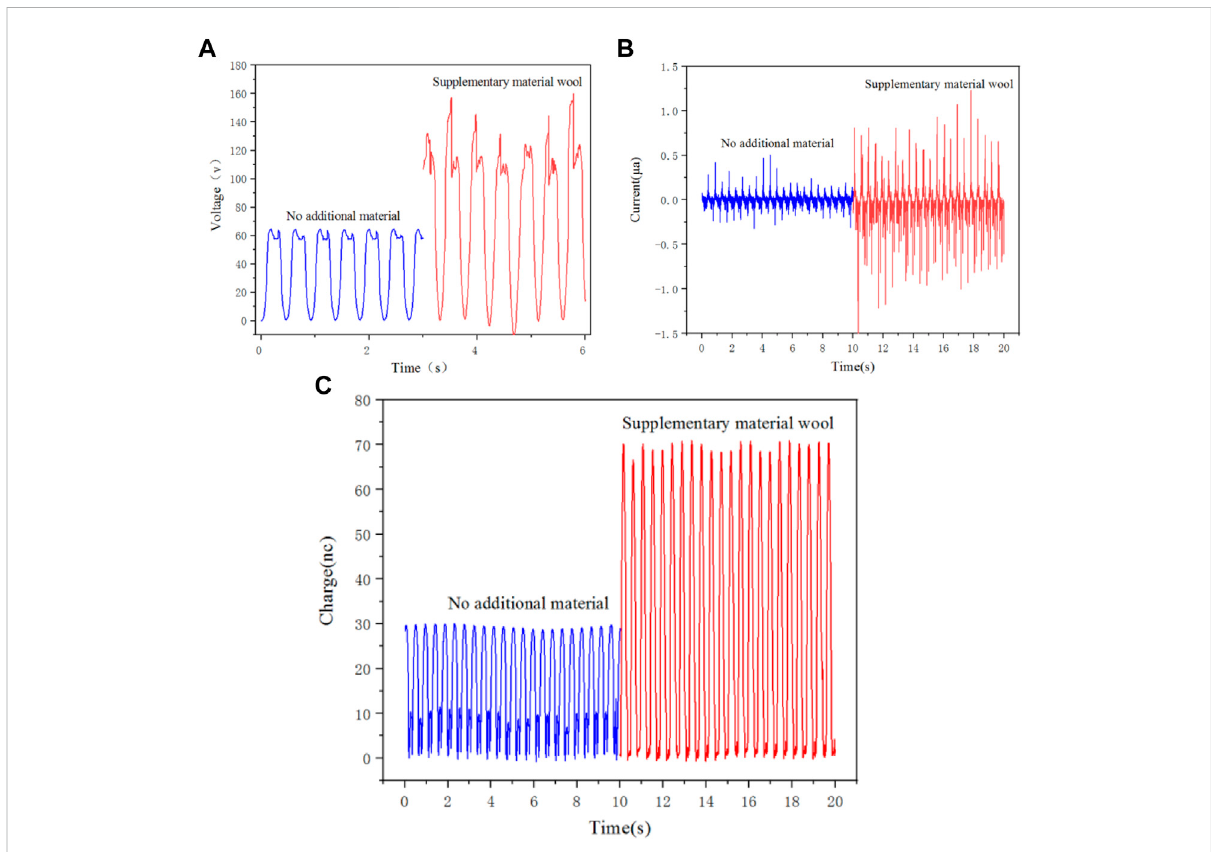
FIGURE 8 Output performance of TENG with and without supplementary materials. (A) Open-circuit voltage; (B) Short-circuit current; (C) Transfer of